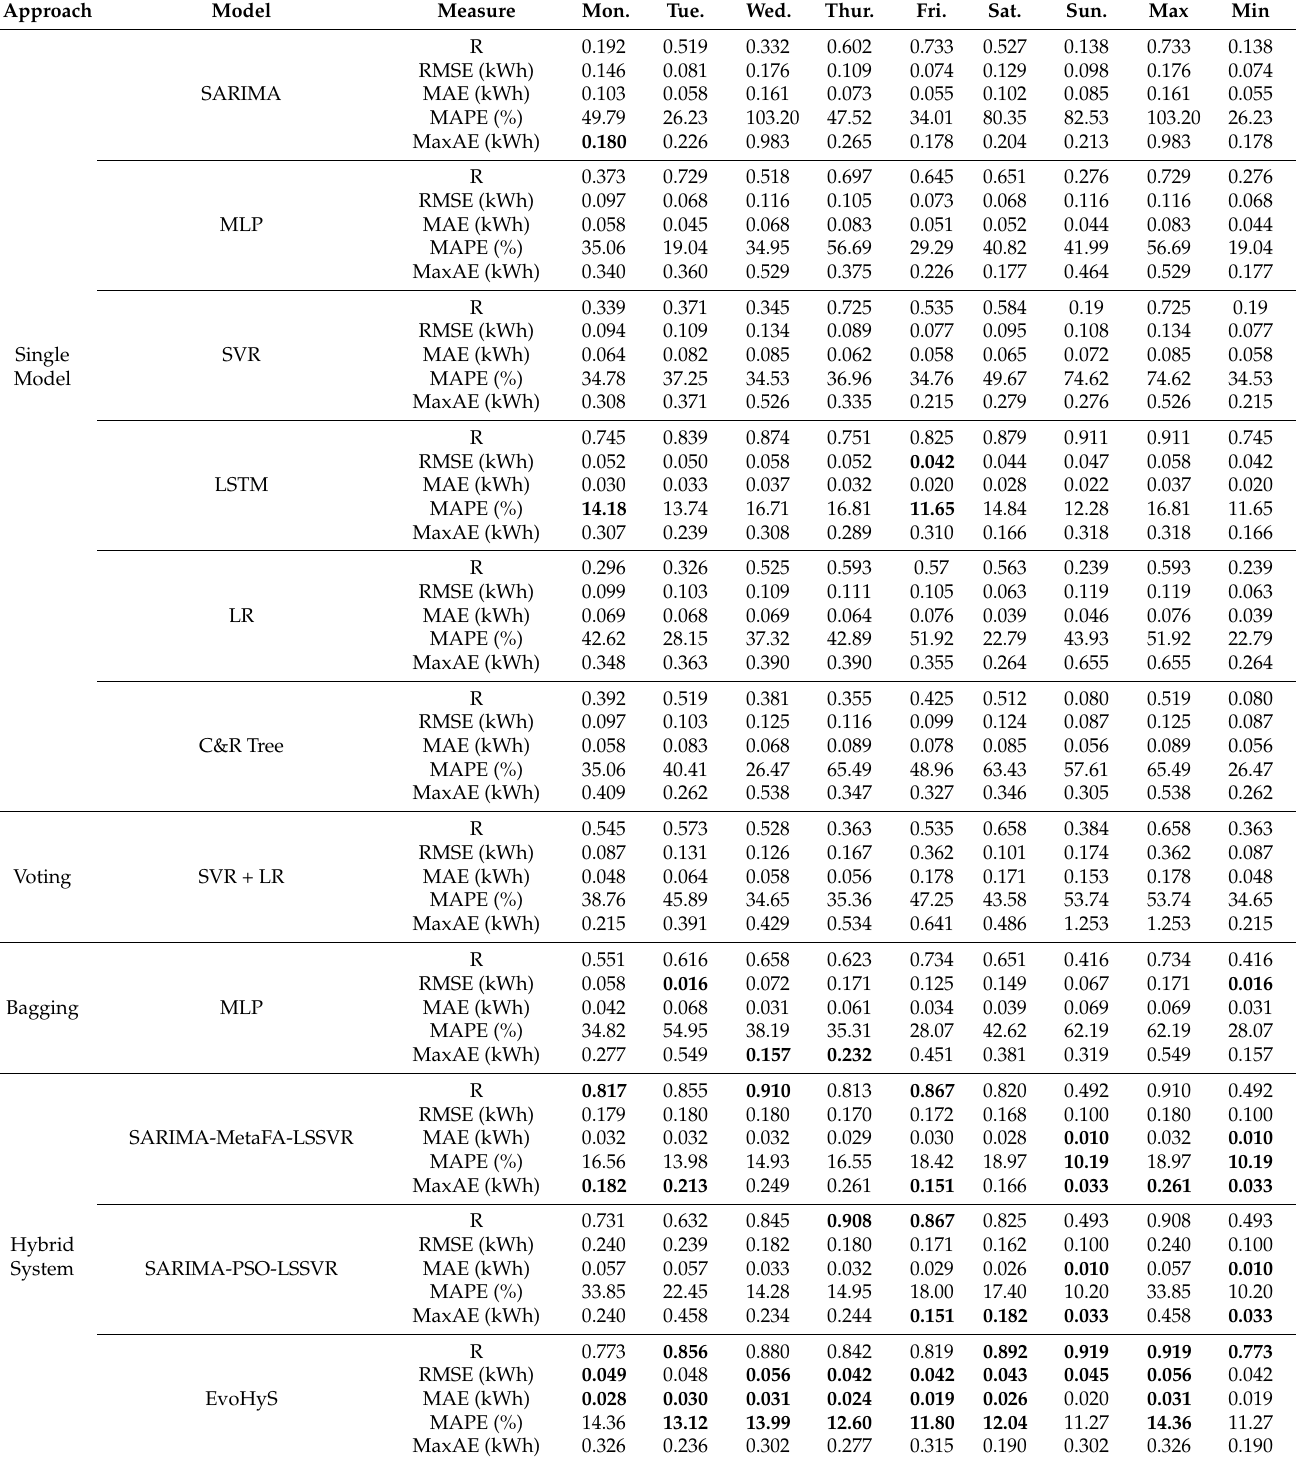
Table 2. The performance of the EvoHyS and literature models in terms of Correlation Coefficient (R), Mean Absolute Percentage Error (MAPE), Mean Absolute Error (MAE), Root Mean Squared Error (RMSE), and Maximum Absolute Error (MaxAE) for each day of the week. The best values are highlighted in